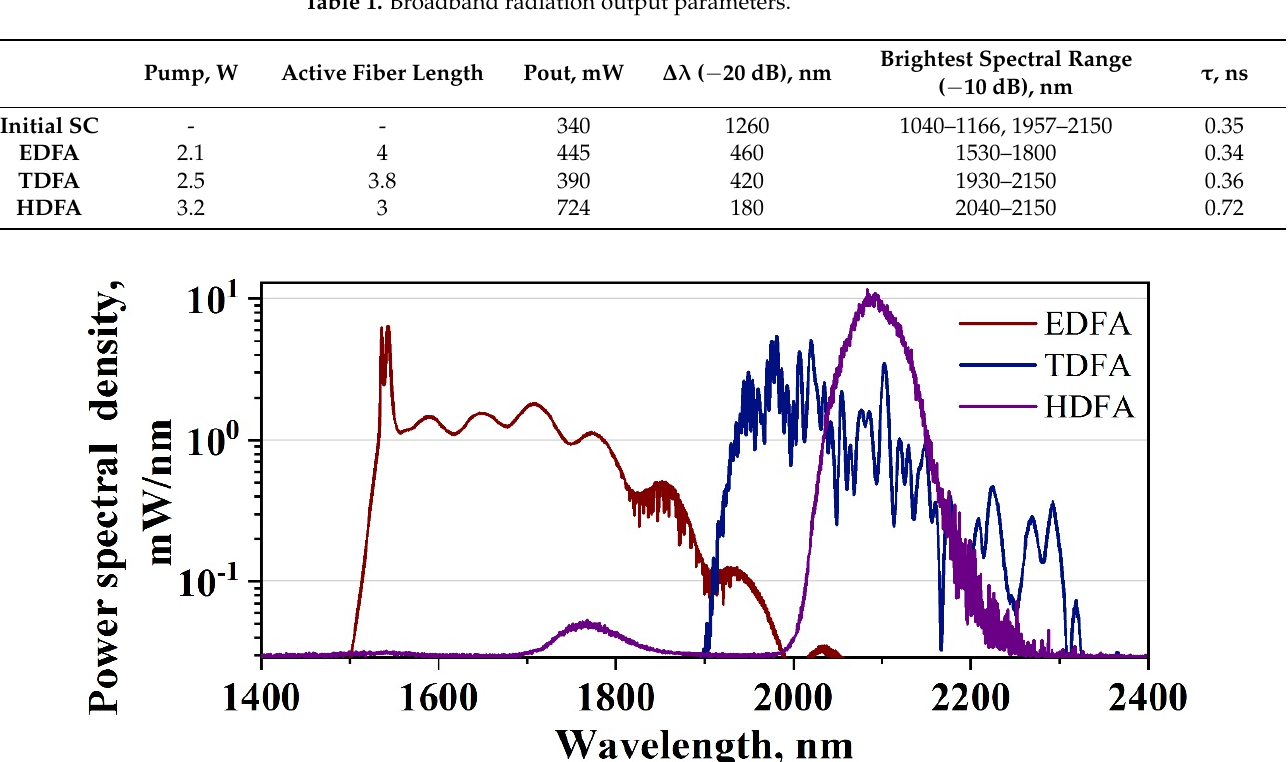
Table 1. Broadband radiation output parameters.